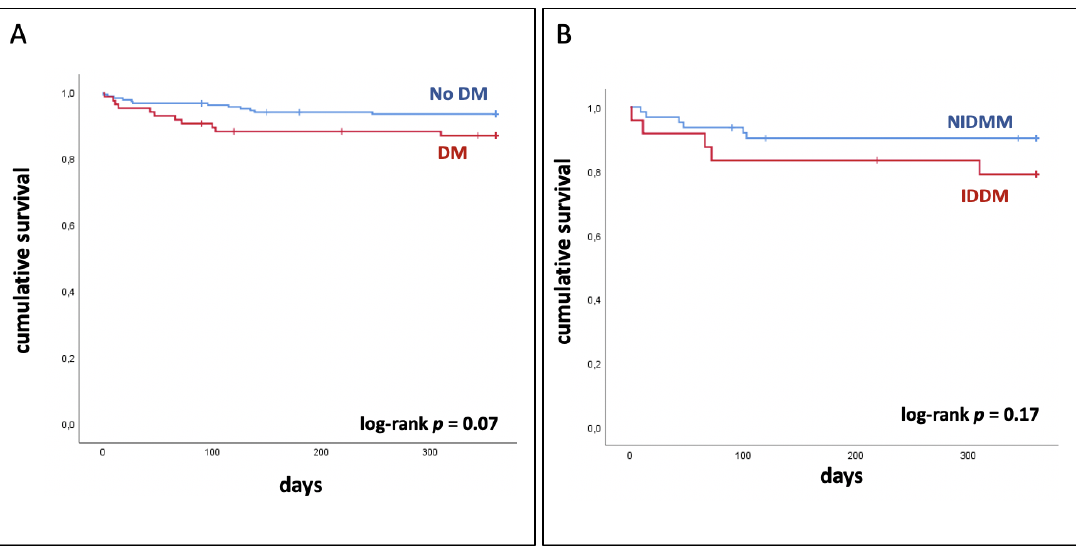
Figure 1. Kaplan–Meier survival curves at one year ( A ) Patients with and without diabetes mellitus (DM) who underwent high-risk percutaneous coronary intervention (PCI). ( B ) Survival curves only for DM patients; IDDM: insulin-dependent diabetes mellitus; NIDDM: non-insulin-dependent diabetes mellitus.